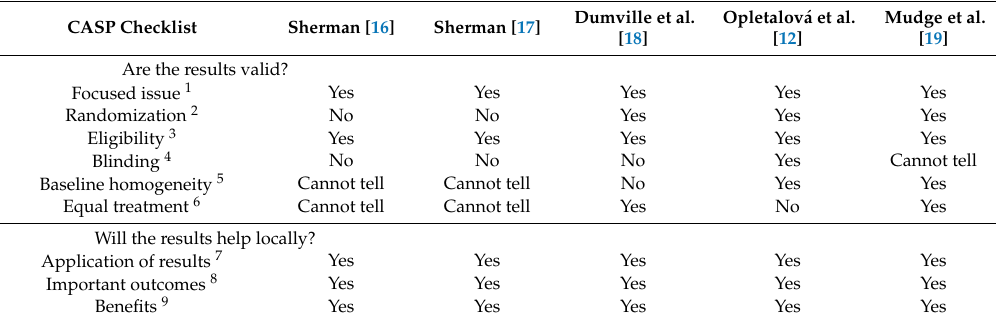
Table 2. Summary of Critical Appraisal Skills Programme checklist for the studies included.